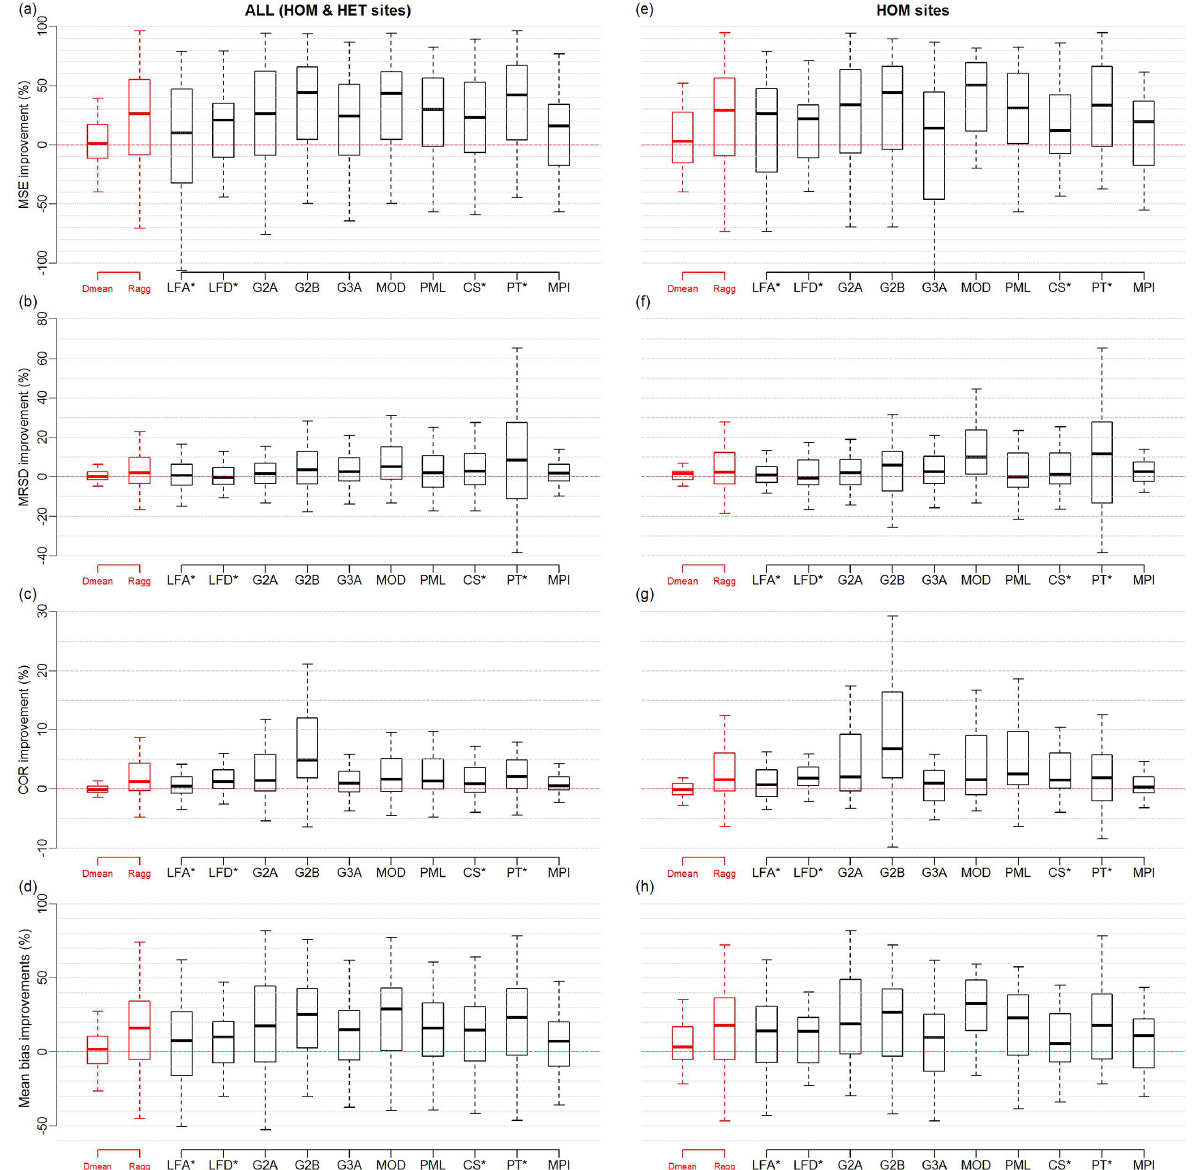
Figure 4. In (a–d) , as for Fig. 3 but showing the one-site out-of-sample test. Box and whisker plots are generated through selecting one site to be out of sample and are repeated for all 138 sites. Products marked with * have limited spatiotemporal availability relative to the diagnostic ensemble, and testing against the LFA, LFD, CS and PT products was limited to 110, 108, 108 and 72 sites respectively. In (e–h) , the one-site out-of-sample test is trained by HOM-case sites data